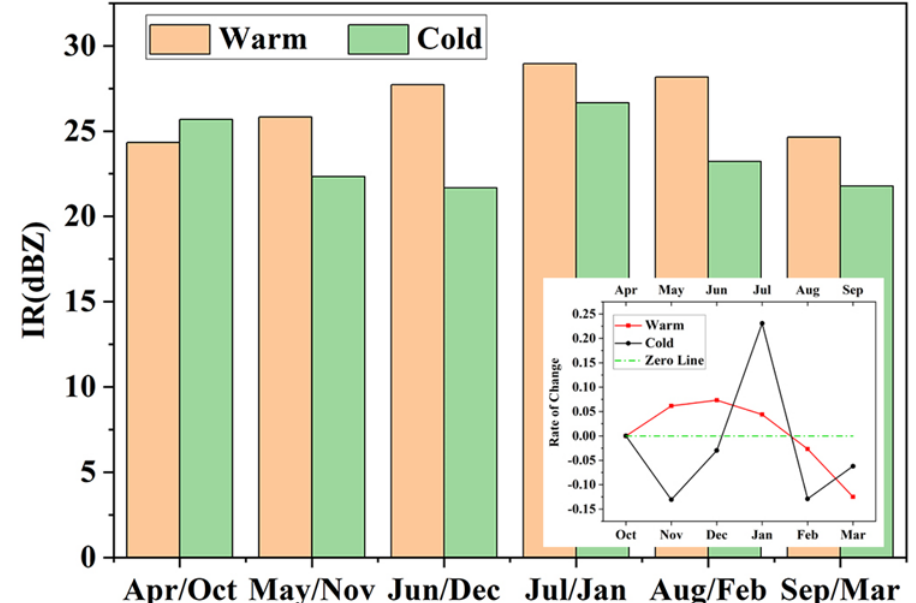
Figure 6. Monthly IR values and change rates in the warm and cold seasons.